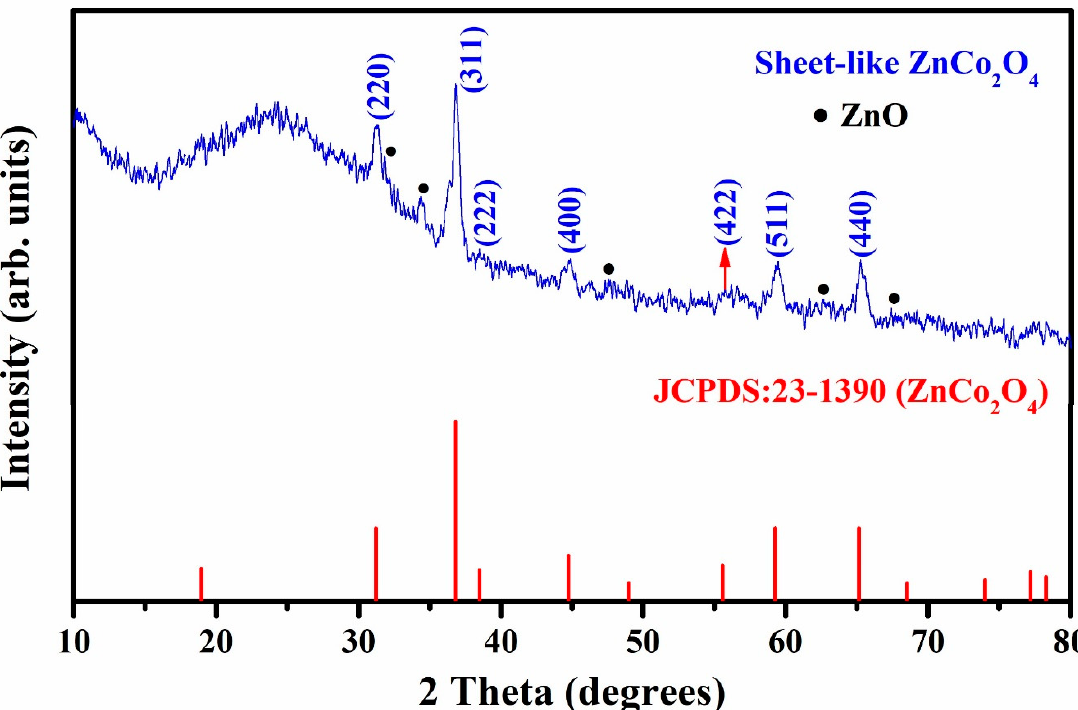
Figure 1. X-ray di ff raction (XRD) pattern for sheet-like ZnCo 2 O 4 Figure 1. X-ray diffraction (XRD) pattern for sheet-like ZnCo 2 O 4.